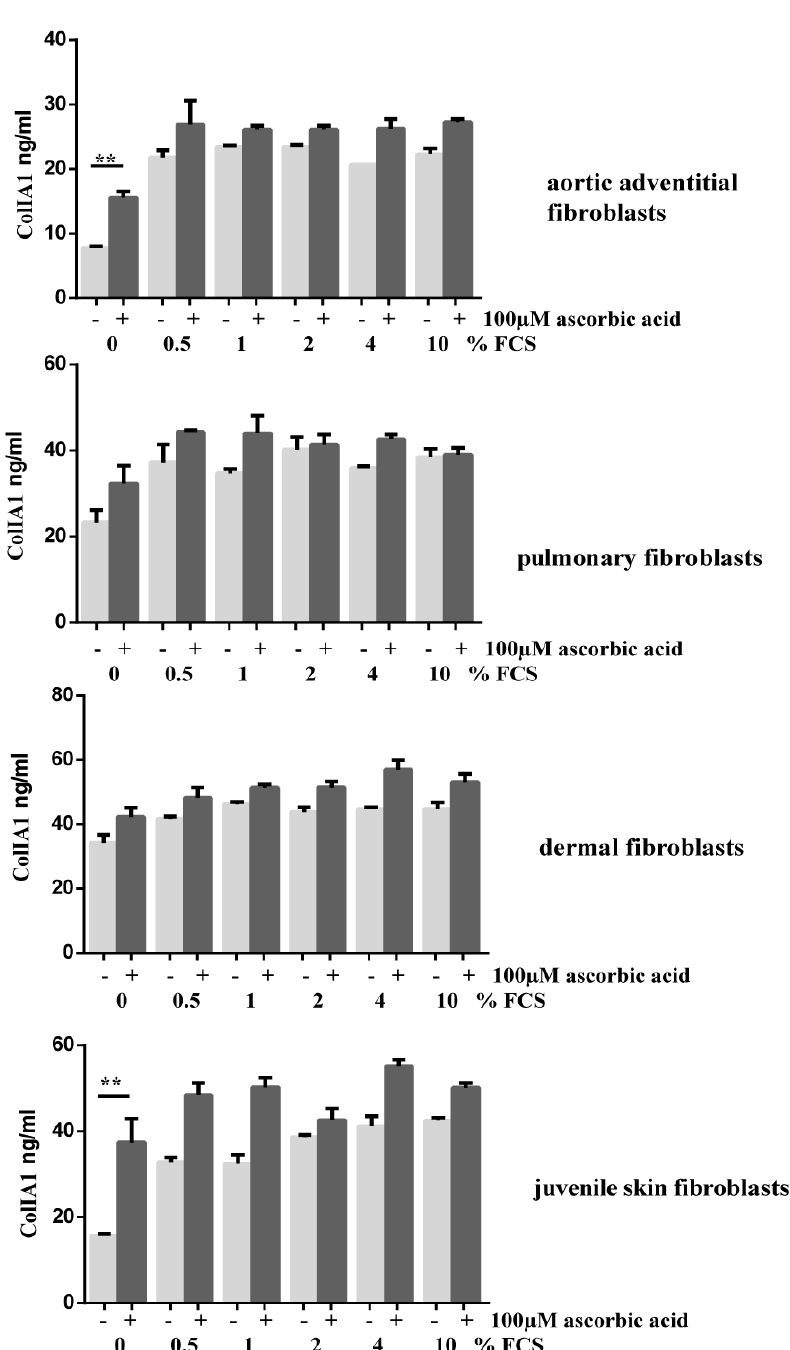
Figure 7. Ascorbic Acid enhances secretion of collagen IA1 in primary fibroblasts with different concentrations of FCS or without FCS. Secretion of collagen IA1 was quantified by ColIA1 specific ELISA: Amounts are demonstrated in ng/mL as columns with standard deviation. ** p < 0.01.